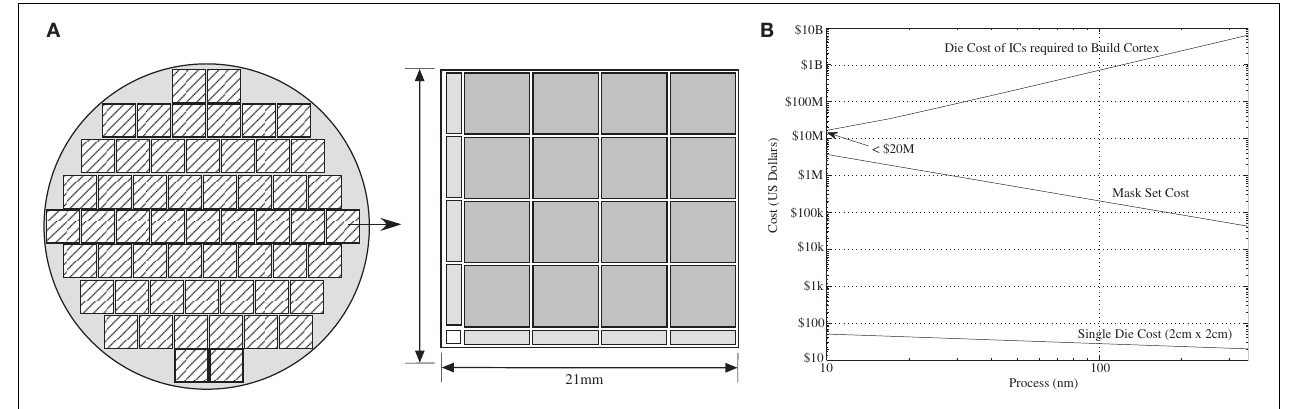
FIGURE 16 | Estimating of cost to build neuromorphic systems. (A) A picture of a wafer, reticle, and mask, and stepping to illustrate the resulting discussion. (B) Estimate of mask cost, die cost, and cost of building a system at the level of human cortex for a physically based computing system. The prices for the mask and die cost are approximate, publically based